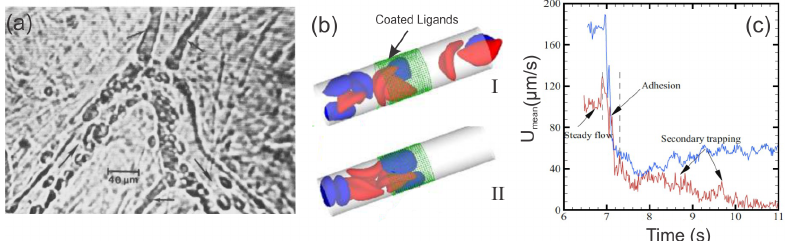
Figure 4. ( a ) SS-RBCs adhere to venular bending and to junctions of smaller diameter postcapillary venules (small arrows) in the isolated mesocecum observed by using intravital microscopy. The large arrows indicate the flow direction. Reproduced from reference[106] with permission. ( b ) Model of SS-RBCs flowing in capillaries. Reproduced from reference [110]. The green dotted region represents the ligands coated on the vessel wall. The blue cells represent the active group of SS-RBCs that exhibits adhesive interaction with the ligands on the wall. The red cells represent the non-active group of cells. ( b . (I)) A snapshot of SS-RBCs in a non-occlusion state, showing the active and non-active cell groups flowing unobstructed within the vessel. ( b .(II)) A snapshot of SS-RBCs in an occlusion state. The active (blue) cells adhere to the wall by interacting with the ligands. ( c ) Mean velocity as a function of time. The red and blue curves correspond to different pressure drops (red: 8.3 × 10 4 Pa/m and blue: 1.35 × 10 5 Pa/m). Prior to adhesion (t < 6.9 s), a steady flow state is reached within the vessel with average velocities of ∼ 115 µ m/s (red), and ∼ 180 µ m/s (blue). When the adhesive forces are turned on (6.9 s < t < 7.3 s), the average velocity exhibits a sharp decrease to ∼ 40 µ m/s, and blood flow exhibits a transition from a steady flow state to a partially (blue) or even completely (red) occluded state. The velocity of the blood flow of the red curve (smaller pressure drop) decreases to ∼ 10 µ m/s, representing the secondary entrapment of the non-active cells and the fully occluded state. Reproduced from reference